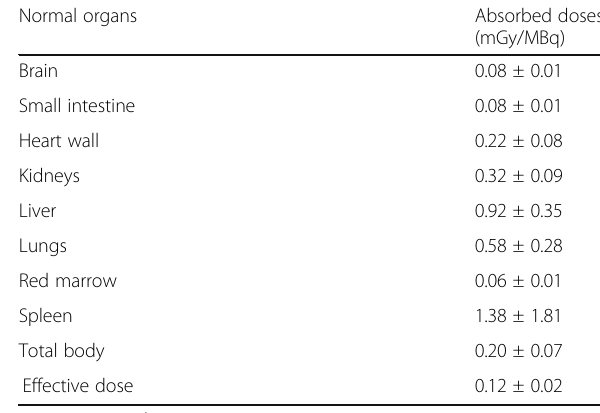
Table 4 Absorbed doses (mGy/MBq) of 188 Re-liposome in